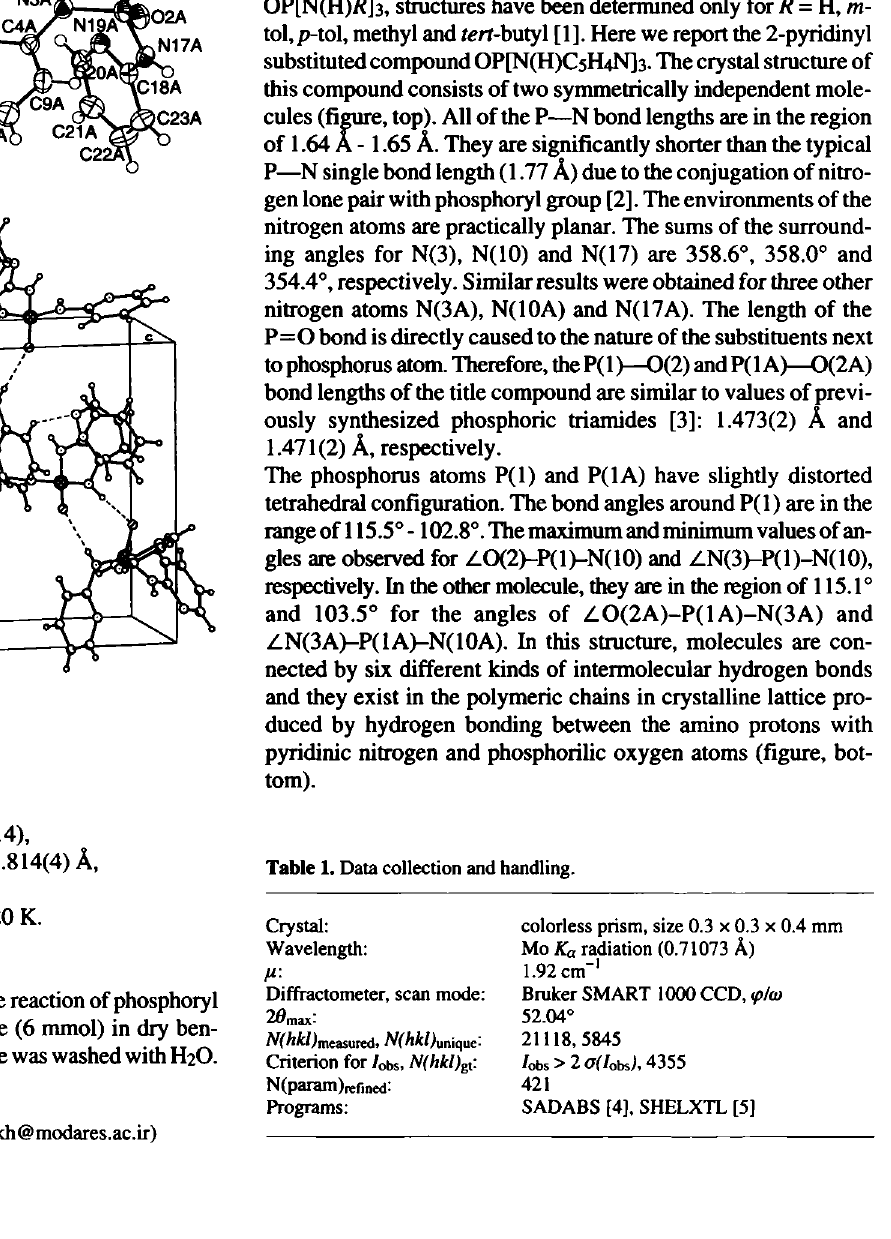
Table 1. Data collection and